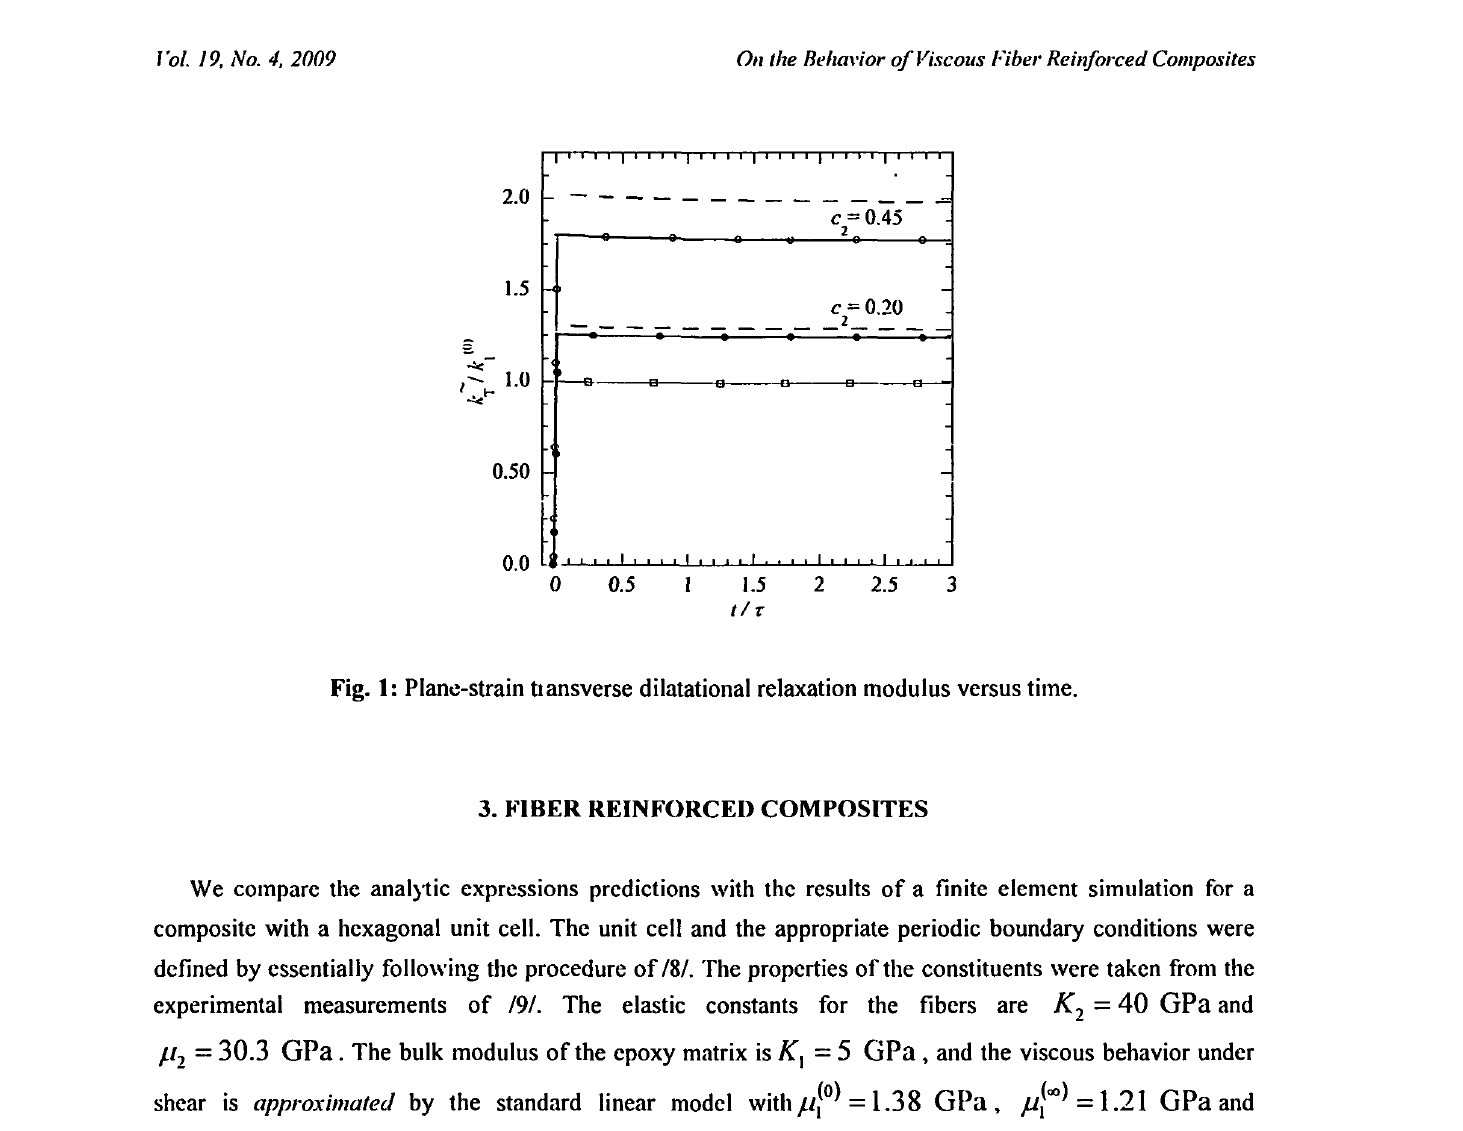
Fig. 1: Plane-strain tiansverse dilatational relaxation modulus versus